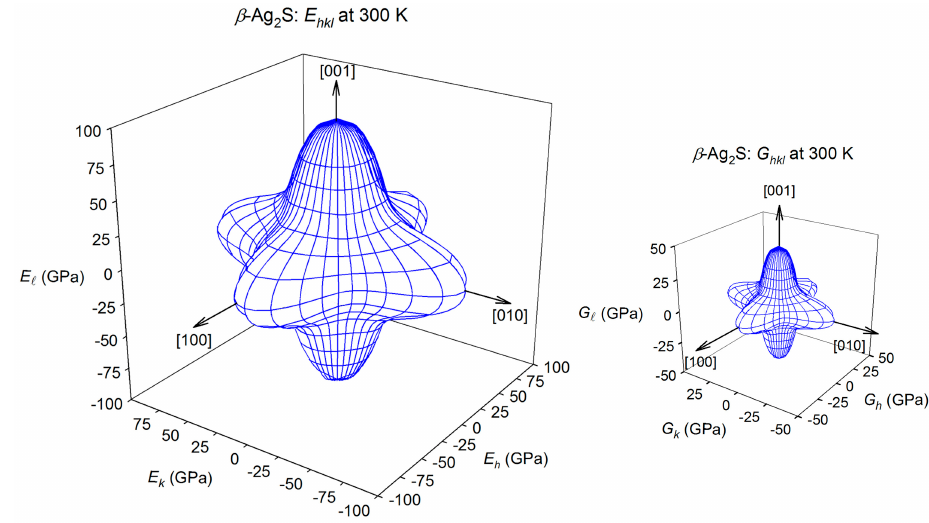
Figure 22. The spatial distributions of the Young’s modulus E hkl and shear modulus G hkl for cubic β -Ag 2 S argentite at 300 K.